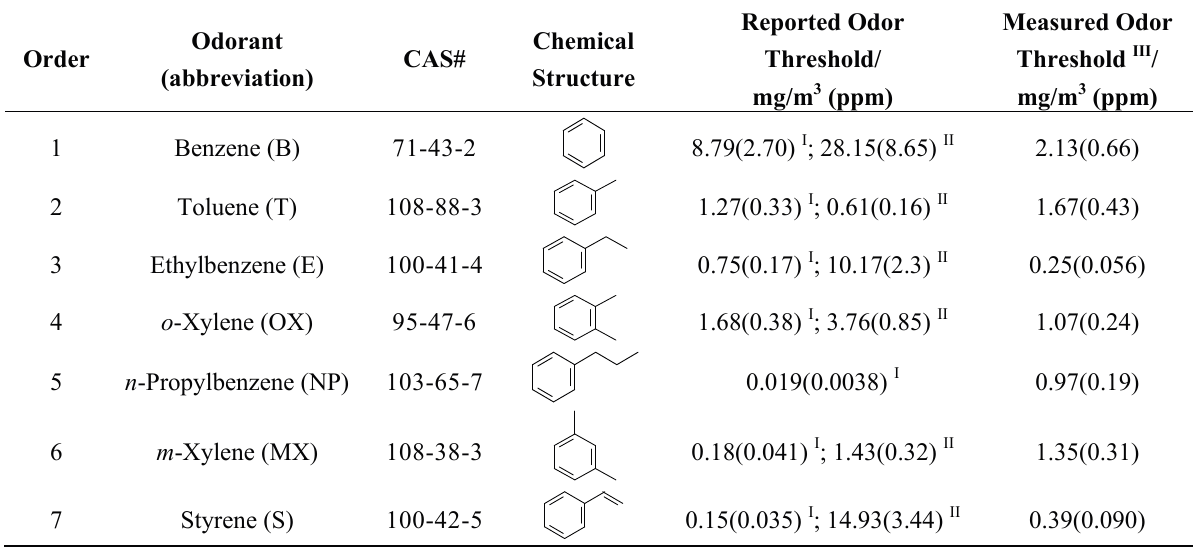
Table 1. List of stimuli investigated for odor interaction